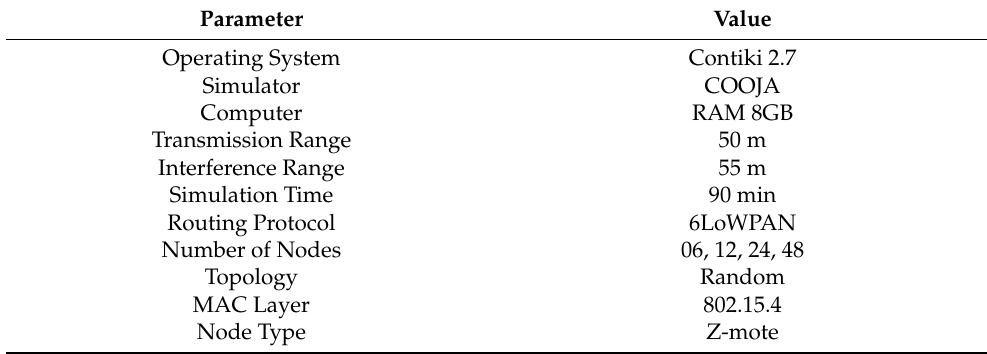
Table 2. Simulation